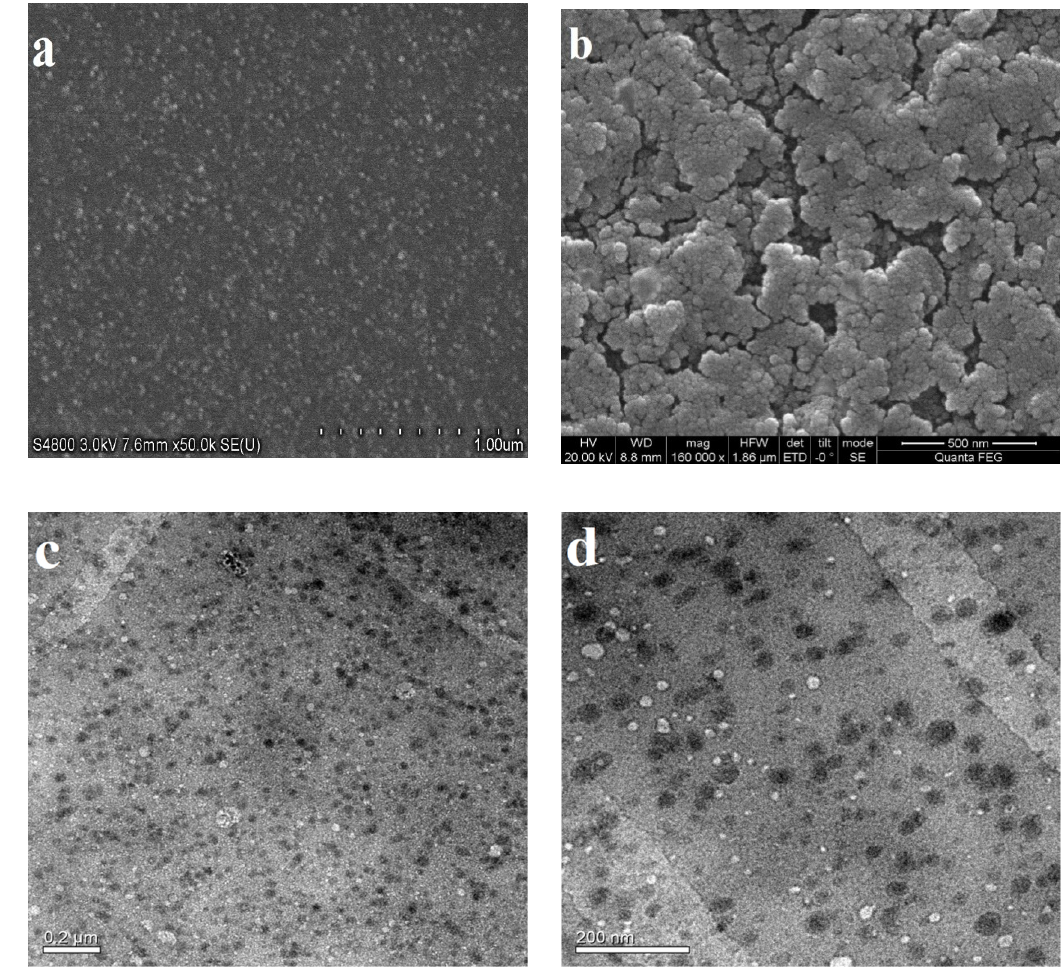
Figure 2. Scanning electron microscopy (SEM) images of FA-AmCS-TPP nanoparticles of component S2 ( a ) and component S10 ( b ). Transmission electron microscopy (TEM) images of FA-AmCS-TPP nanoparticles of component S2 ( c ) and the enlarged image ( d ).